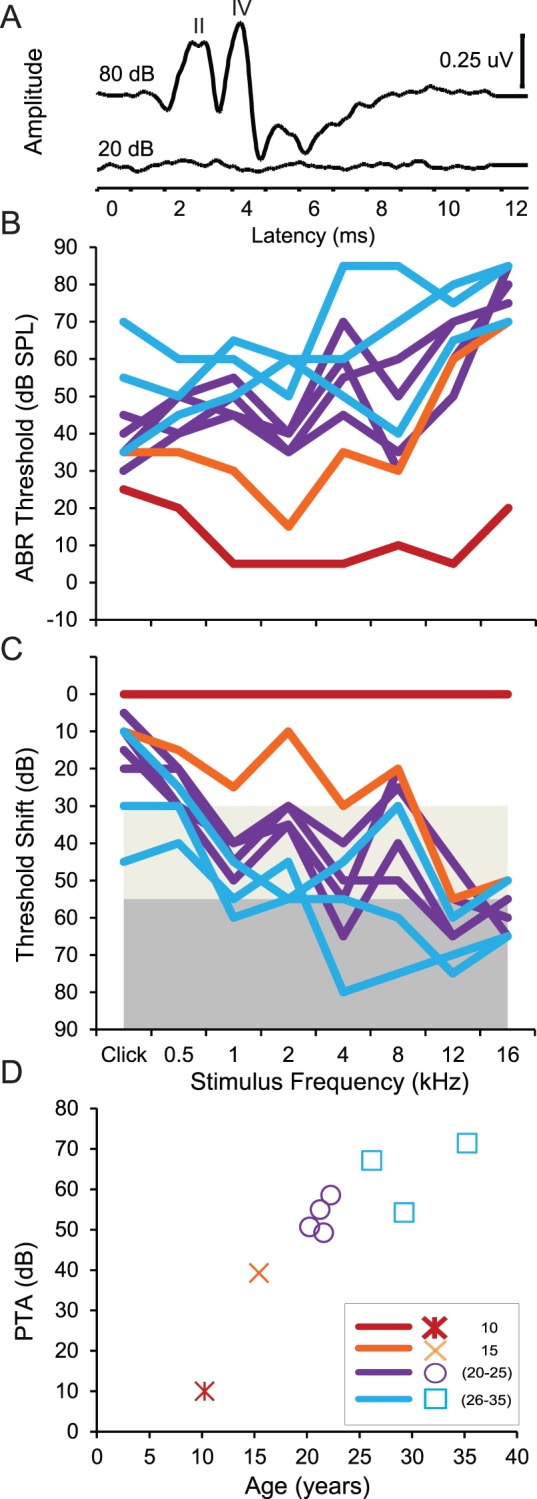
Auditory brainstem response (ABR) measurements of age-related hearing loss.Panel A shows two representative ABR waveforms from the youngest monkey. Waves II and IV are marked. The top trace shows the response to click stimuli presented at 80 dB SPL, which was well above threshold, and the bottom trace shows the response in the same monkey to a 20 dB SPL click stimulus. No obvious response was noted at this stimulus intensity. Panels B-D show the data from each monkey organized by symbols and colorized to represent different age-groups. ABR thresholds (B) and age-related shift in threshold (C) as a function of stimulus and age of the monkey. The seven frequency pure tone average loss (PTAL; Panel D) increases as a function of age, r = 0.88, p<0.01.